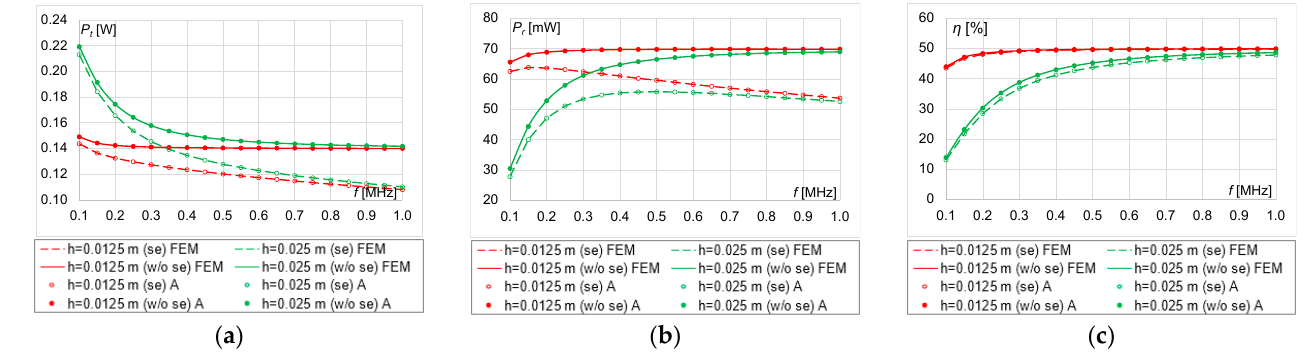
Figure 21. Results for n = 50 for the cases with and without skin effect: ( a ) P t , ( b ) P r , ( c ) η .